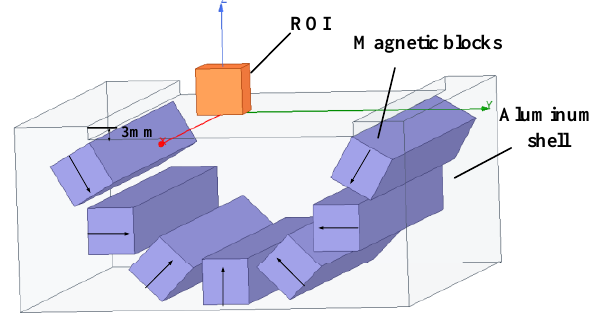
Figure 4. The schedule of the magnet. The arrows in Figure 4 indicate the magnetization direction of each magnetic rod. The magnetic field distribution in the optimized ROI is shown in Figure 5. In the direction perpendicular to the magnet surface, the static magnetic field decays from 96 mT on the coil surface to 80.4 mT at z = 4 mm, and the magnetic field has a flatter gradient characteristic along the z-axis, with an approximate gradient of 3.9 T/m, corresponding to an RF frequency variation of 166 kHz/mm.